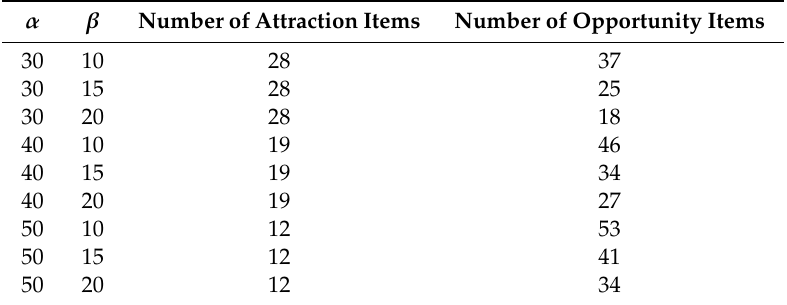
Figure 9. Relationship between betweenness centrality and α value in TBN. Table 7. Number of attraction and opportunity items using betweenness centrality.